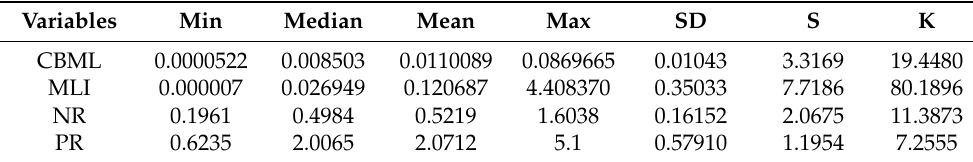
Table 1. Descriptive statistics (daily